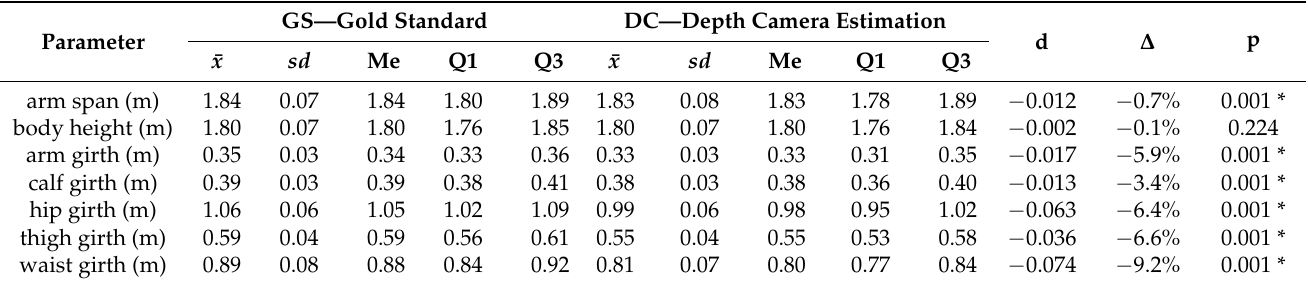
Table 1. Characteristics of the anthropometric parameters for GS and DC methods ( N = 129). GS—Gold Standard DC—Depth Camera Estimation Parameter